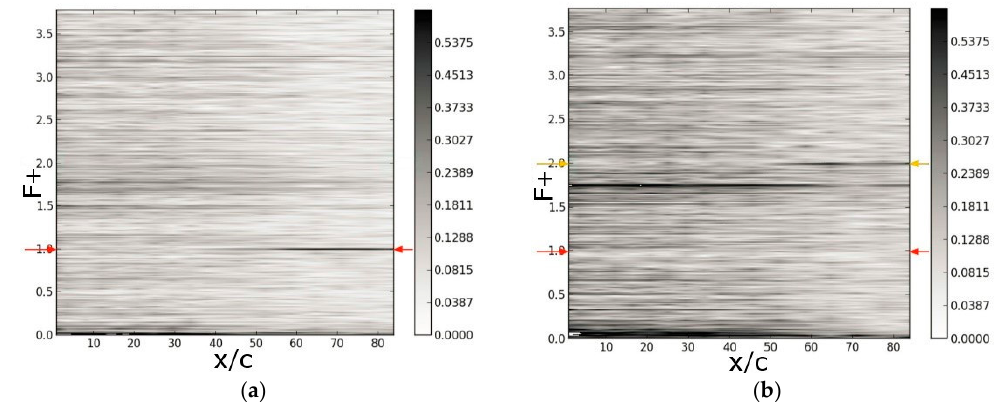
Figure 38. Wing glove wind tunnel measurements for Re = 115,000 and α = 8 degrees. Temporal Fourier transforms of wall pressure coefficient versus chord length. Active flow control with F + = 1.0 and ( a ) B = 0.002 and ( b ) B = 0.1. (Reprinted by permission of the American Institute of Aeronautics and Astronautics, Inc. (Reston, VA, USA) from [37]).